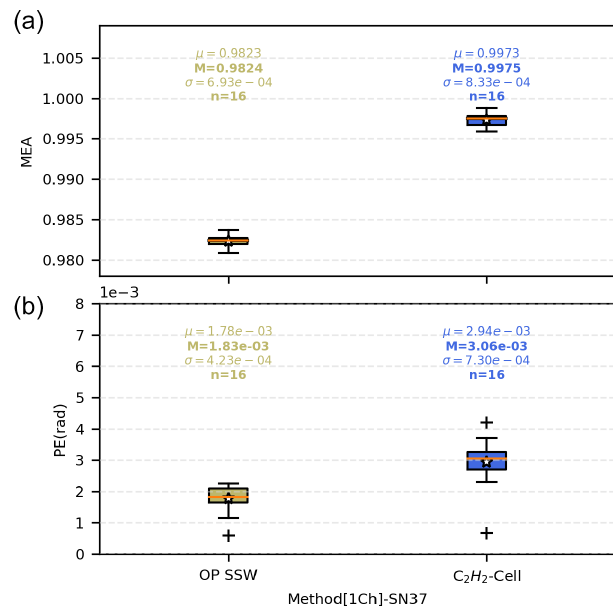
Figure 16. Same as Fig. 9 but for the sensitivity study for the COC- CON reference instrument SN37. Left part of the display: open-path results; right part: cell